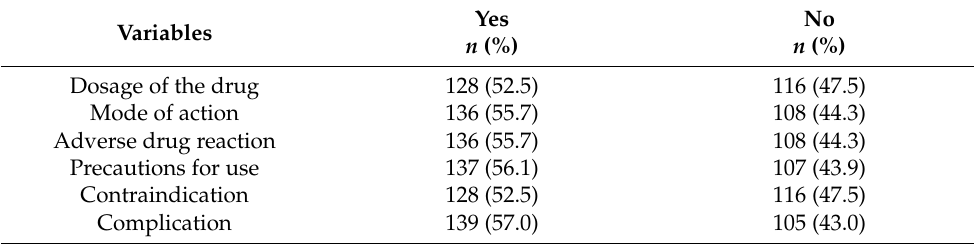
Table 7. Students’ knowledge towards self-medication ( n = 244).